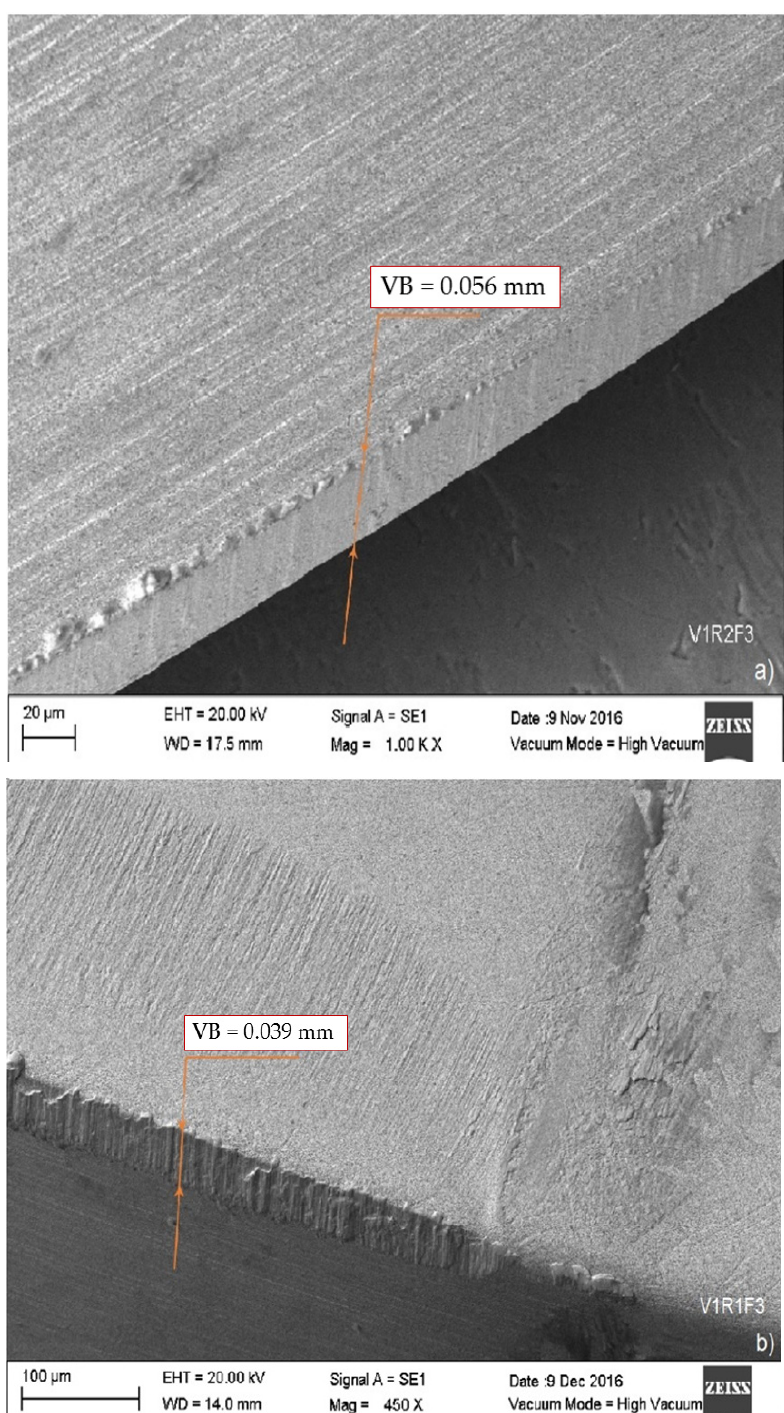
Figure 6. Wear on the incidence surface of the cutting tool for V = 200 m/min and f = 0.1 mm/rev: ( a ) dry and ( b ) with MQL.